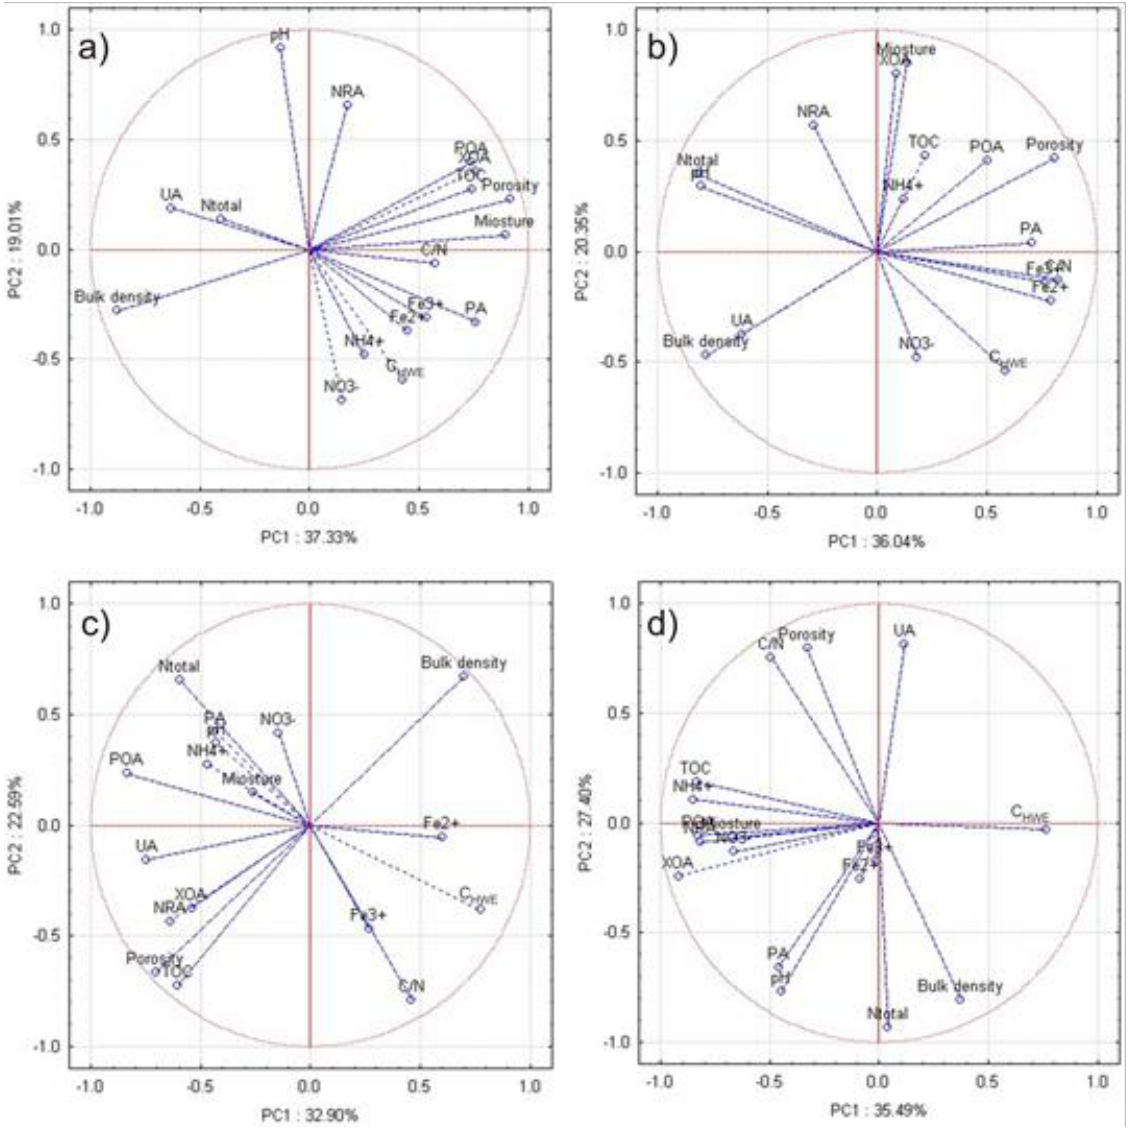
Figure 4. Eigenvectors of soil chemical variables in a) Carex -dominated peat soils 0–50 cm, b) Carex - dominated peat soils 50–100 cm, c) Sphagnum -dominated peat soils 0–50 cm, d) Sphagnum -dominated peat soils 50–100 cm, where: Ntotal - total nitrogen, TOC - total organic carbon, C organic carbon, UA - urease activity, NRA - nitrate reductase activity, PA - peroxidase activity, XOA - xanthine oxidase activity, POA - phenol oxidase